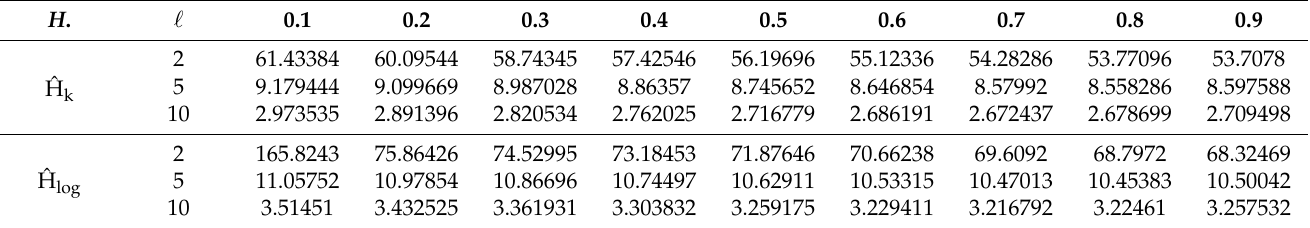
Table 1. Comparison of asymptotic variance of H k and H log .